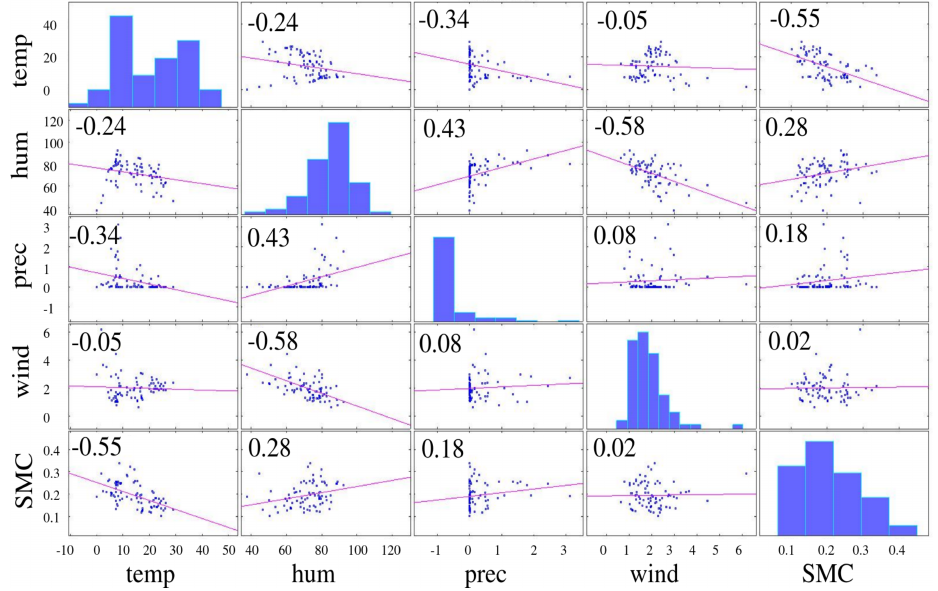
Figure 11. Correlation